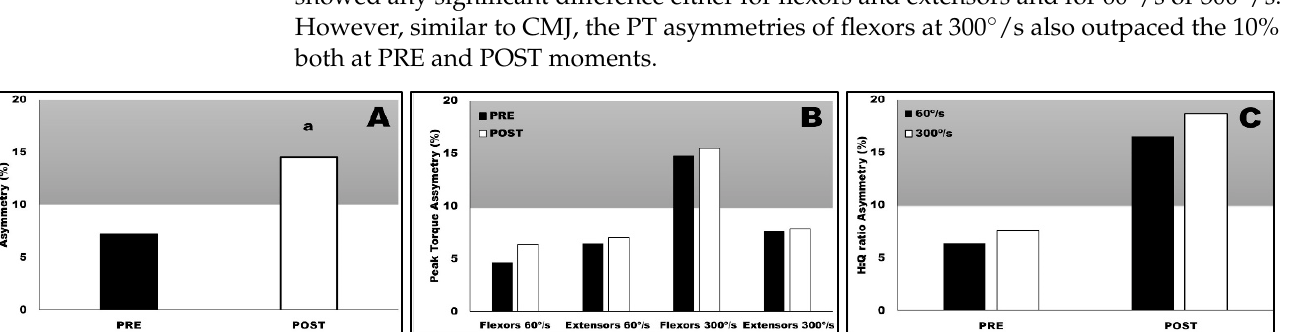
Figure 2. Peak torque ( A ) and H:Q ratio (%) ( B ) at 60°/s and at 300°/s either for DOM and NDOM limbs and both in PRE and POST moments. FLEX = flexors; EXT = extensors; DOM = dominant leg; NDOM = nondominant leg; PRE = prior to the in-season starting; POST = after 15 weeks of a competitive period; a = different than DOM at the same period ( p ≤ 0.05); b = different than PRE for the same leg or muscle group ( p ≤ 0.05). The gray area (<75%) indicates an injury risk zone.